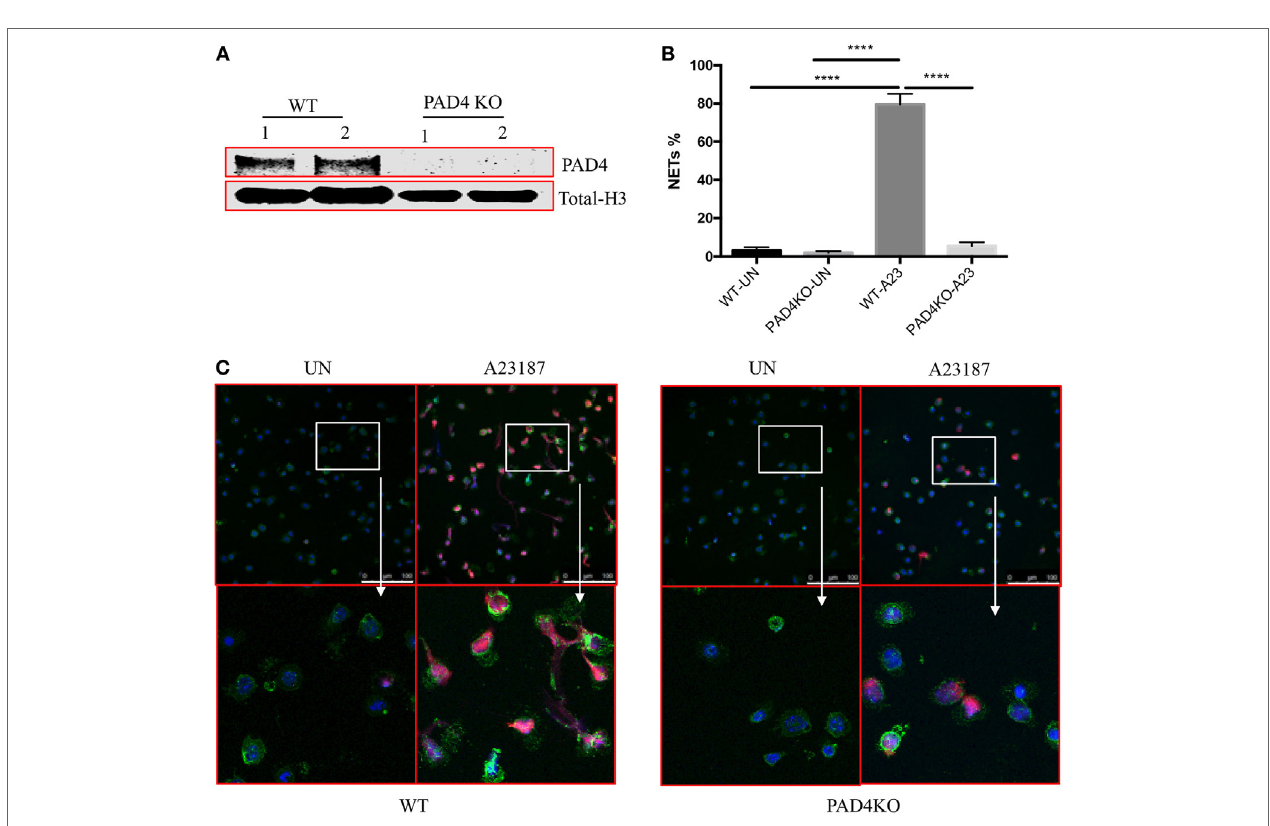
FigUre 1 | Neutrophil extracellular traps (NETs), but not macrophage extracellular traps (METs) are present in atherosclerotic lesions and are associated with the development of atherosclerosis. (a) WT mice were fed with high-fat chow (HFC) for indicated weeks, and aortic root sections were stained for NETs markers and observed by confocal immunofluorescence microscopy. Blue: DAPI, green: MPO, red: Ly-6G, and cyan: Cit-H3. Data are representative of four mice in each time point. NETs are indicated by white arrows. (B) WT mice were fed with HFC for 5 weeks, and aortic root sections were stained for METs markers (blue: DAPI, green: MPO, red: F4/80, and cyan: Cit-H3) and observed by confocal immunofluorescence microscopy. Lower panel represents higher magnification of the NETs area (white square) in the upper panel. Macrophages are indicated by white arrows. (c) Quantification of NETs formation from (a) ( n = 4 per time points). Results represent the mean ± SEM. (D) Higher magnification of (B) for characterizing macrophages. Right panel represents overlay channels of DAPI (blue) and F4/80 (red) of the NETs area (white square) of left panel. Macrophages are indicated by white